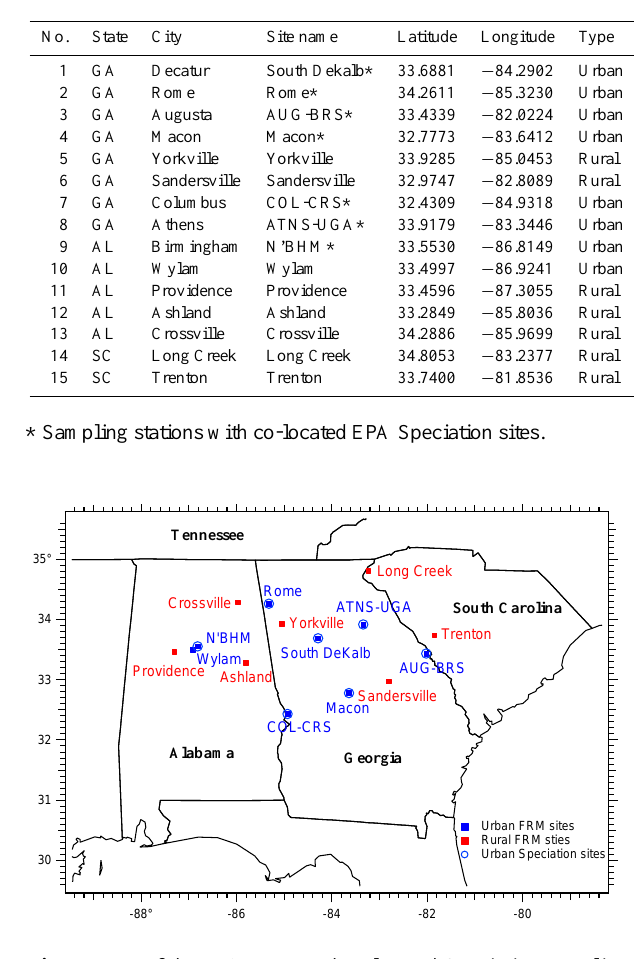
Fig. 1. Map of the EPA FRM and co-located Speciation sampling sites used in this study. Site names and locations are given in Ta- ble 1.